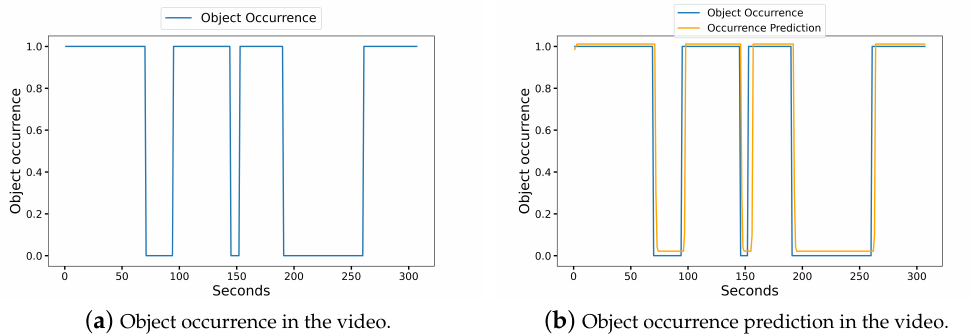
Figure 6. Object occurrence in the sample video and its pretrained LSTM-based prediction.